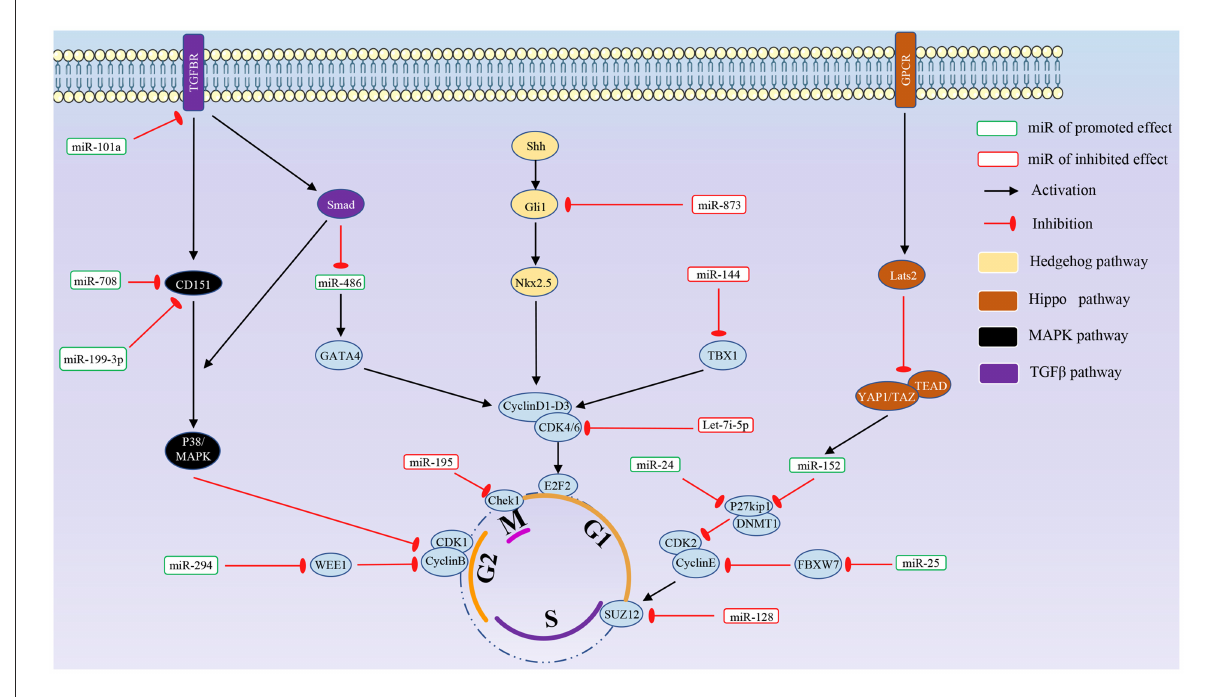
FIGURE1 The effects of different miRNAs that directly act on the cell cycle.